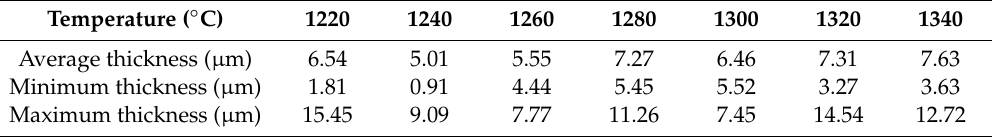
Table 3. Thickness of oxide layers of the Fe-Cr-Al-Ti-Zr steel oxidized at di ff erent temperatures for 3 h. Temperature ( ◦ C)